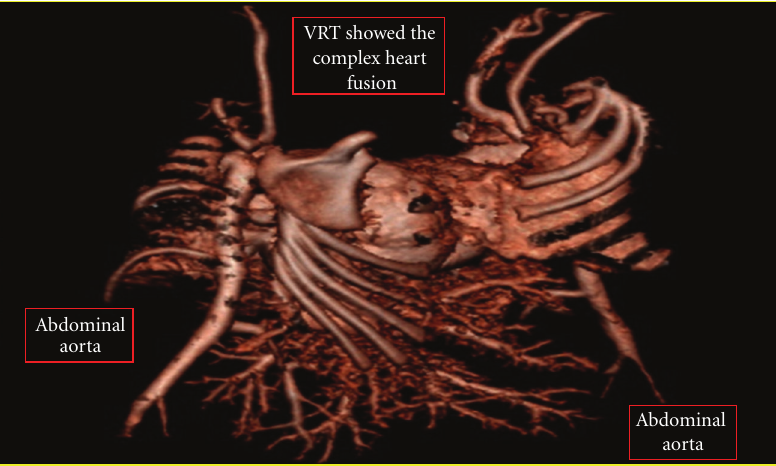
Figure 4: 3D image of the cardiac fusion in twins A and